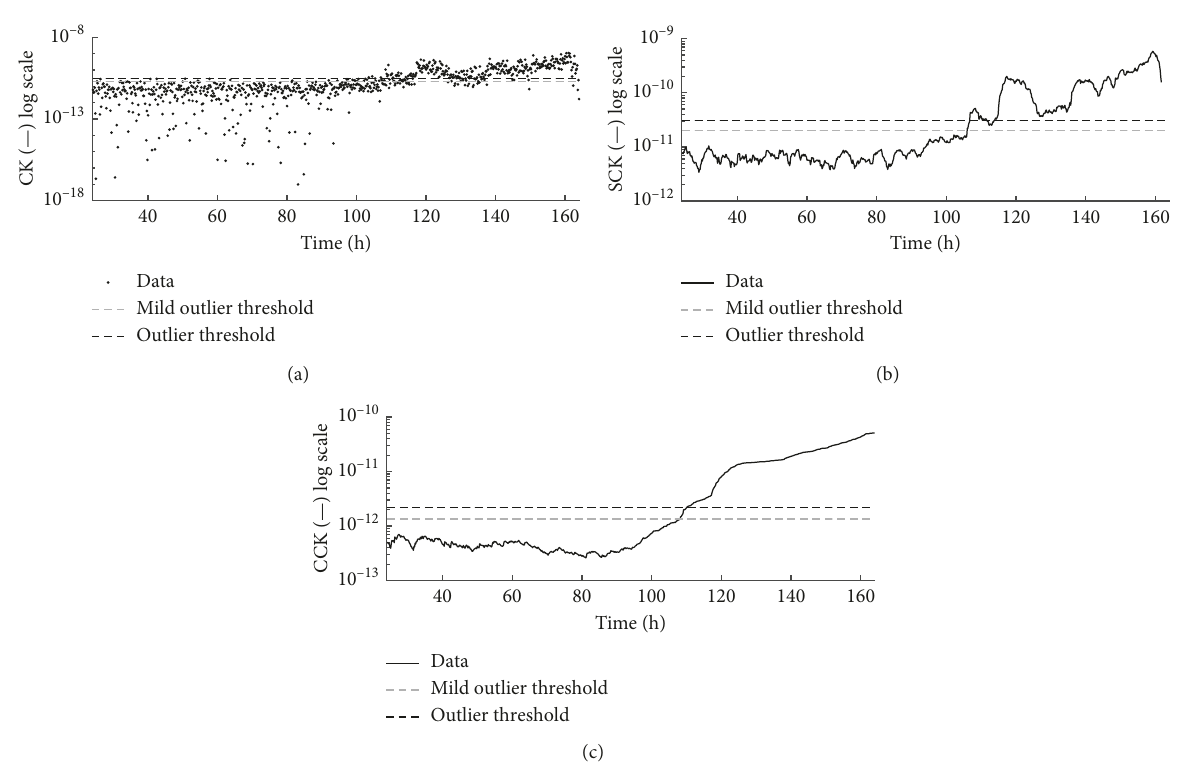
Figure 6: Application of the proposed method with MCKD: (a) CK values, (b) smoothed CK values (moving average), and (c) cumulative CK values. The considered prior period is referenced to the outer race bearing